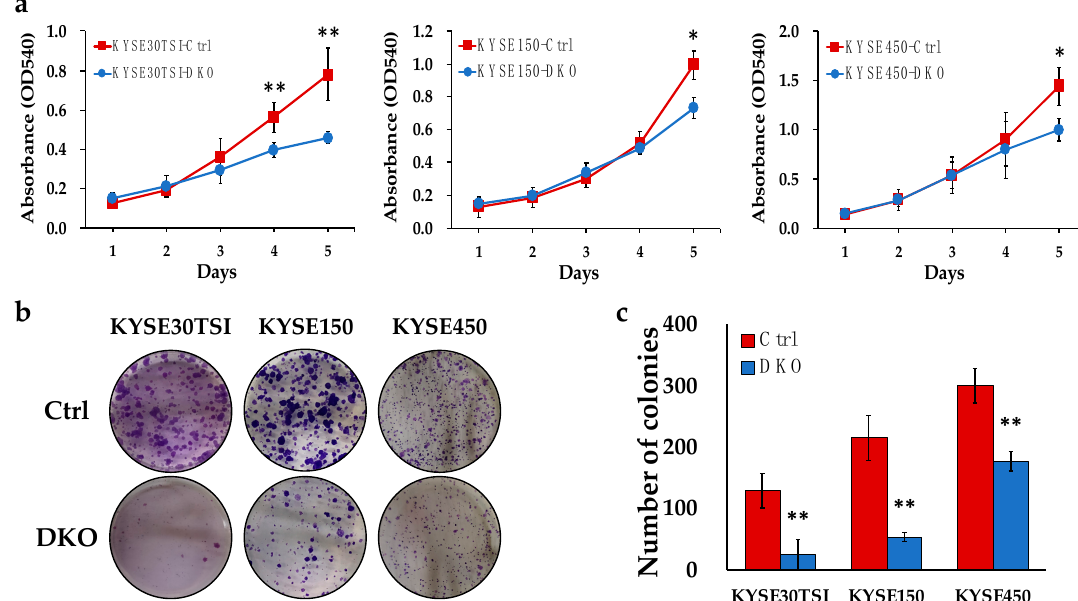
Figure 3. FANCD2 expression regulates in vitro cell proliferation and colony formation. ( a ) Cell proliferation was suppressed as assessed by MTT assay in FANCD2-KO ESCC cell lines. The data are shown as the mean ± 95% confidence interval ( n = 3). ( b ) Representative images of colony formation assays are shown. ( c ) Colony formation ability was suppressed in FANCD2-KO ESCC cell lines. Data are representative of three independent experiments done in triplicates and expressed as the mean ± 95% confidence interval ( n = 3). Ctrl, control; DKO, FANCD2 knockout; * p < 0.05; ** p < 0.01.